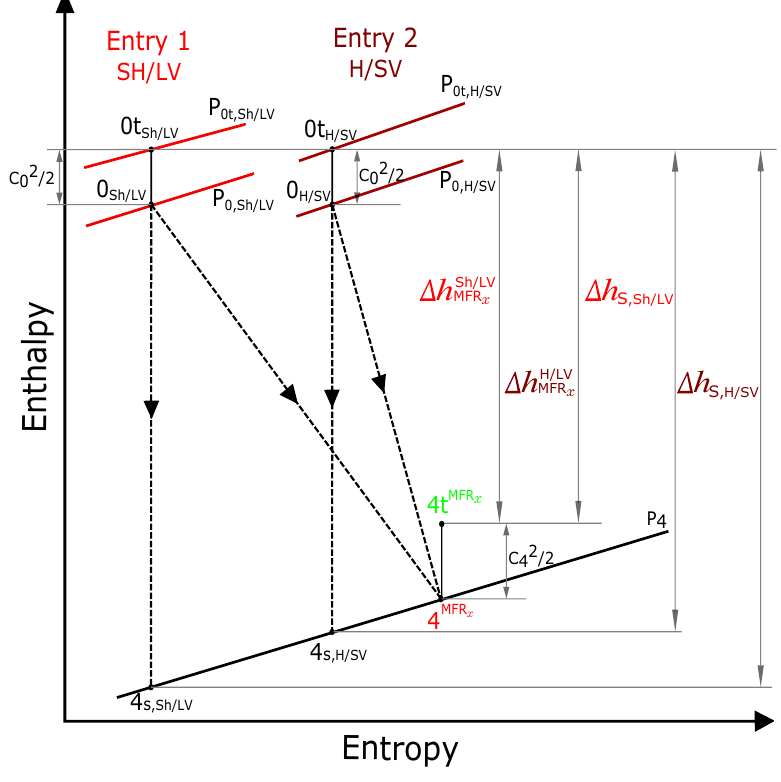
Figure 5. Enthalpy–entropy expansion process in twin-entry/dual-volute radial